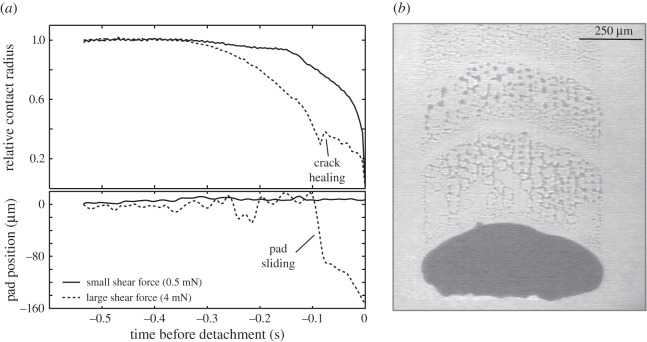
(a) During detachment, the contact radius of the pads—approximated as the ratio between pad area A and perimeter Γ—decreased continuously. The change of A/Γ with time may be interpreted as the speed of a crack propagating through the interface [35], which was measured by performing an ordinary least-squares regression of A/Γ against time for the last 50 ms of detachment (‘terminal’ crack speed, figure 4). When shear forces were small, the crack initially accelerated, followed by approximately steady crack growth until detachment was complete. When shear forces were large, however, we sometimes observed that the crack was arrested or even receded, i.e. detached parts of the pad re-attached (top panel). This ‘crack-healing’ was clearly associated with the onset of fast sliding, i.e. the pad's position relative to the surface changed (bottom panel). (b) When pads were slid across a surface, they left a trail of fluid behind.